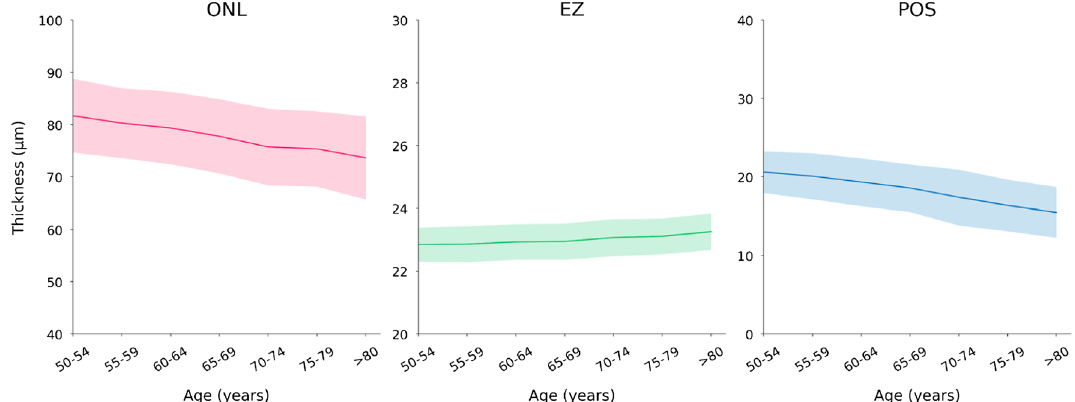
Figure 3. Graph showing the age-related change (mean value (line) and standard deviation (shadow)) in the thickness of retinal outer nuclear layer (ONL), ellipsoid zone (EZ), and photoreceptor outer segment band